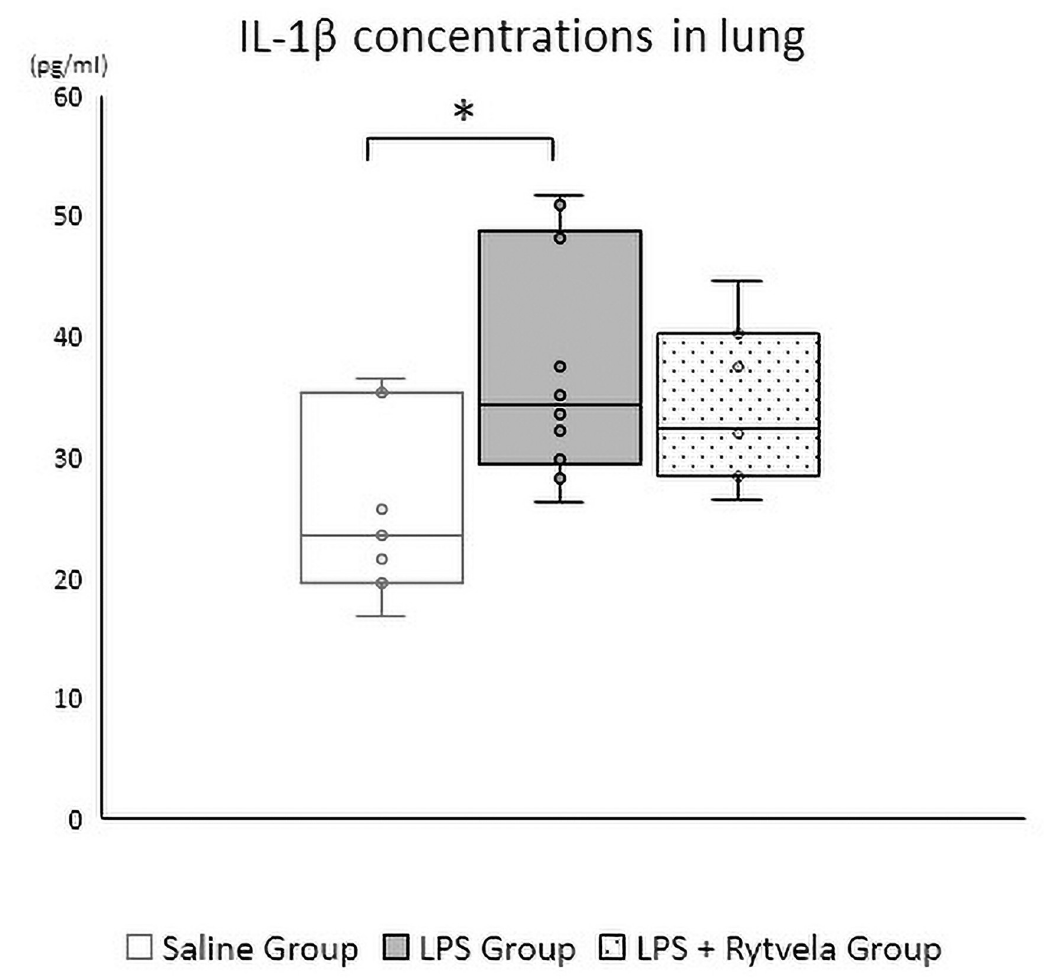
Fig 4. IL-1 β protein concentrations in fetal lung at delivery. � p < .05 vs. the Saline Group. Plots show median, 25th, and 75th percentile ranges as boxes and 5th to 95th percentile as error bars. n = 7–10 animals/group IL,